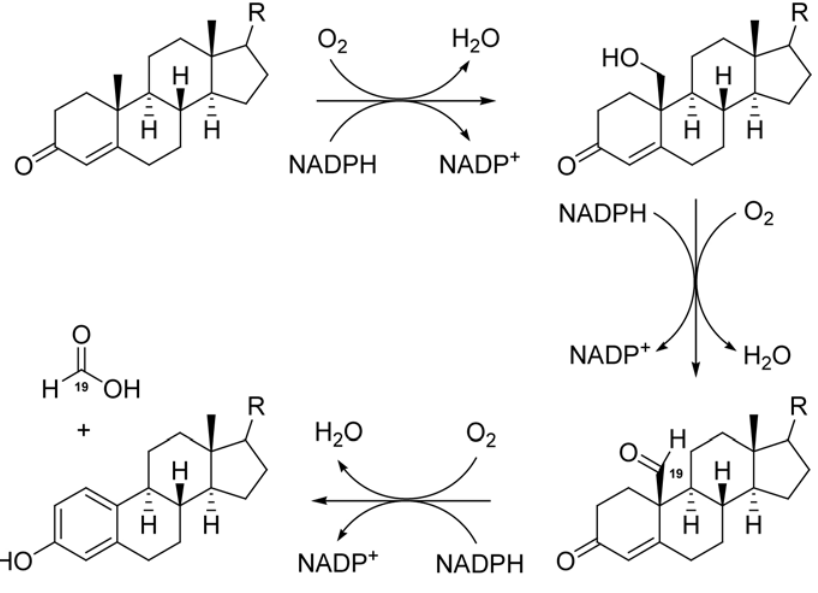
Figure 1. Estrone and estradiol biosynthesis mediated by aromatase (R = O,